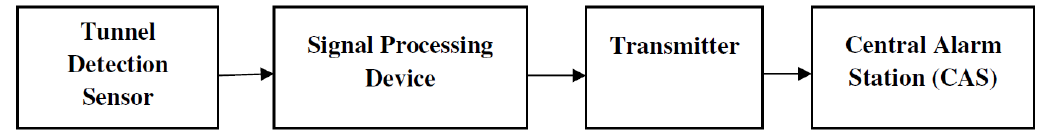
Figure 3. Block diagram of the tunnel threat detection